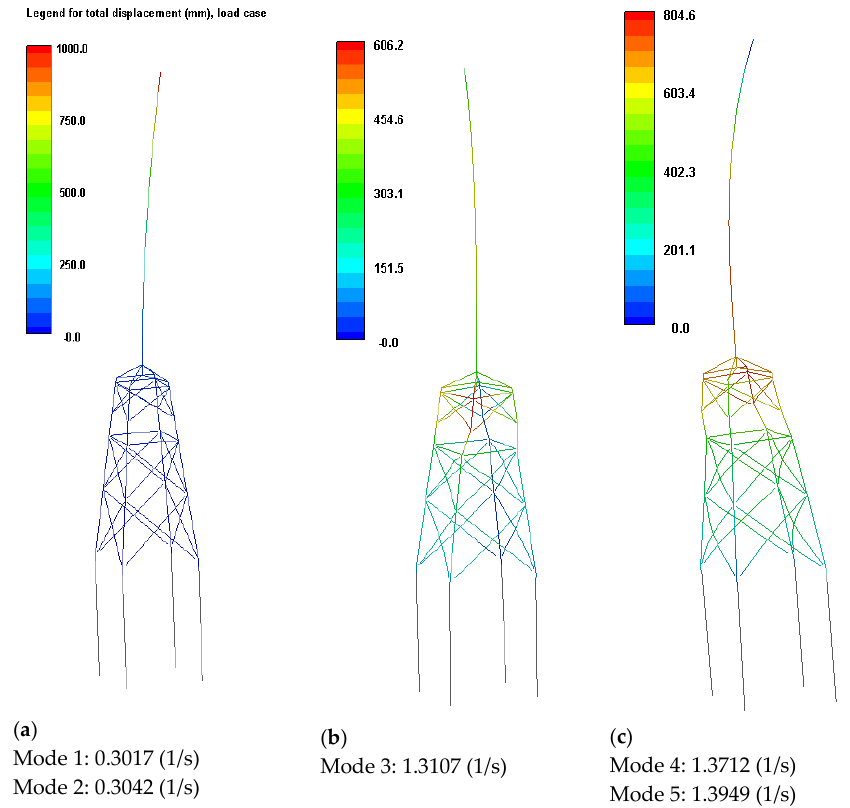
Figure 3. Shapes of first five modes along with their respective frequencies. Colored by total displacement. ( a ) Tower modes 1 and 2, ( b ) torsional mode 3, ( c ) swaying modes 4 and 5.